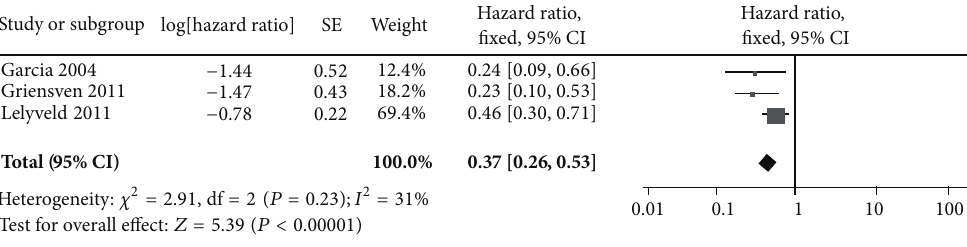
Figure 2: Forrest plot of > 500cells/ 𝜇 L group hazard ratios.